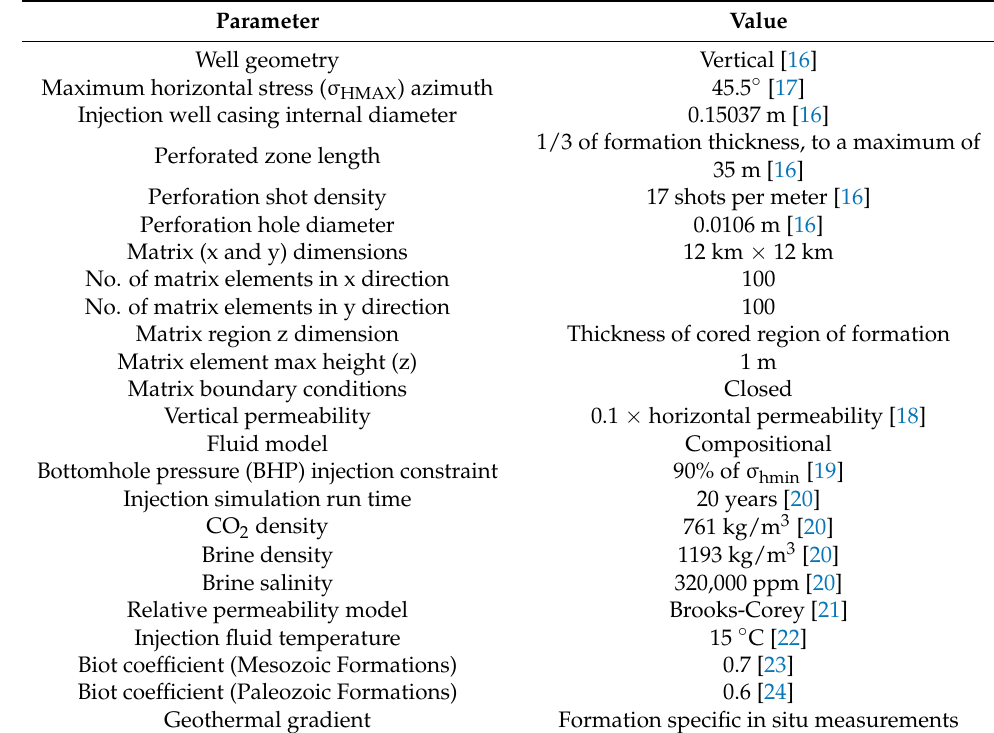
Table 4. Common injection parameters used in all